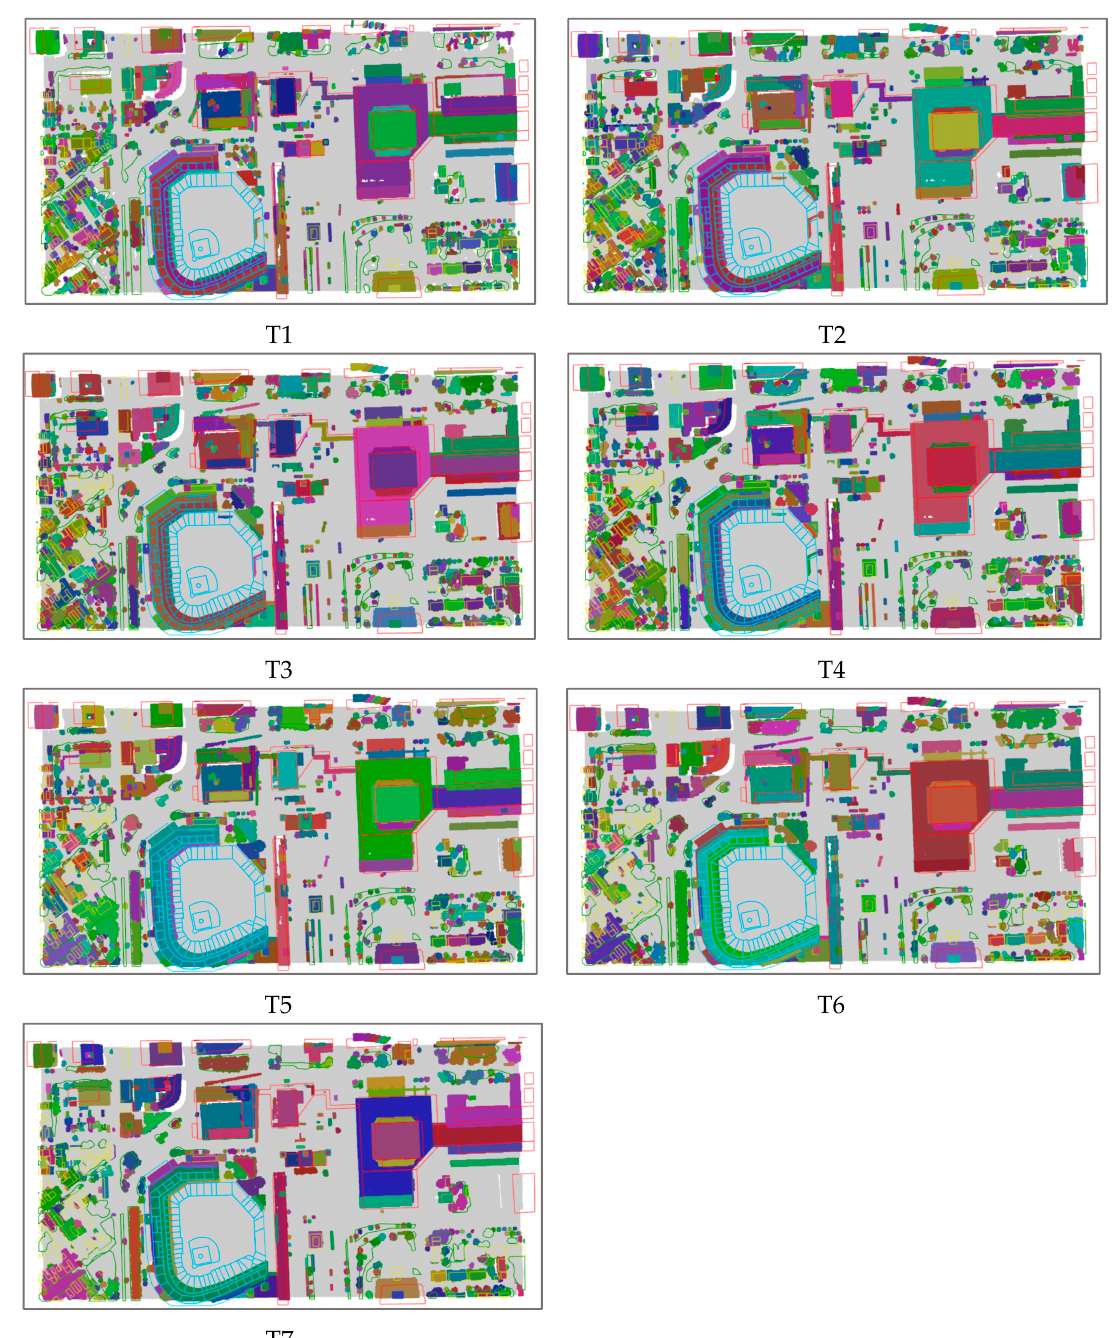
Figure 8. Airborne laser scanning data segmentation result maps using X , Y , Z fields.